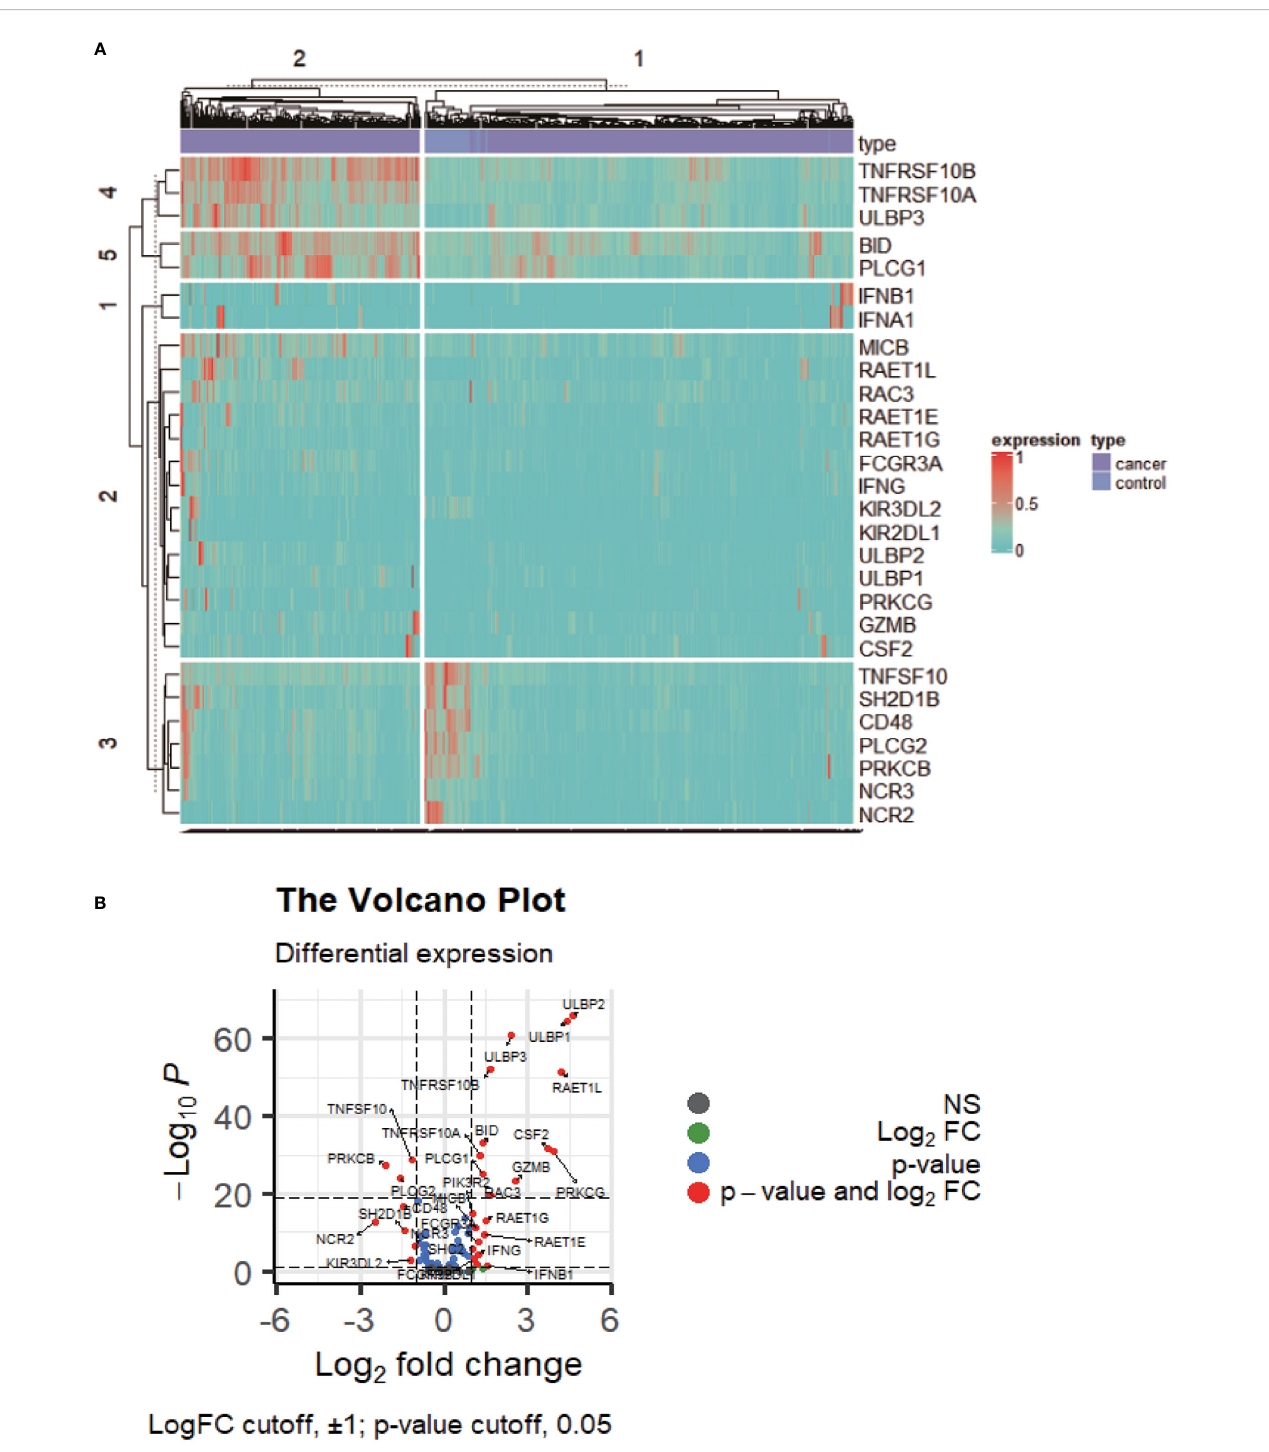
FIGURE 1 The expression pro fi le of NKCP genes. (A) : Heat map of NKCP gene expressions in colon cancer normal control group vs cancer tissues. (B) : Volcanic map of NKCP gene